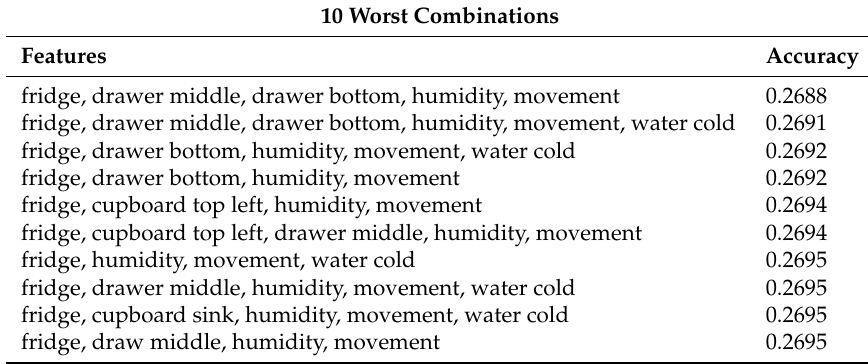
Table 7. Accuracies for the 10 worst and 10 best sensor combinations without the camera